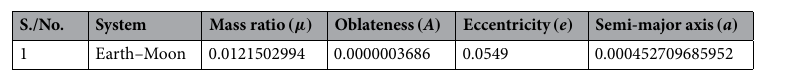
Table 3. Numerical data in a dimensionless form for the Earth–Moon system.